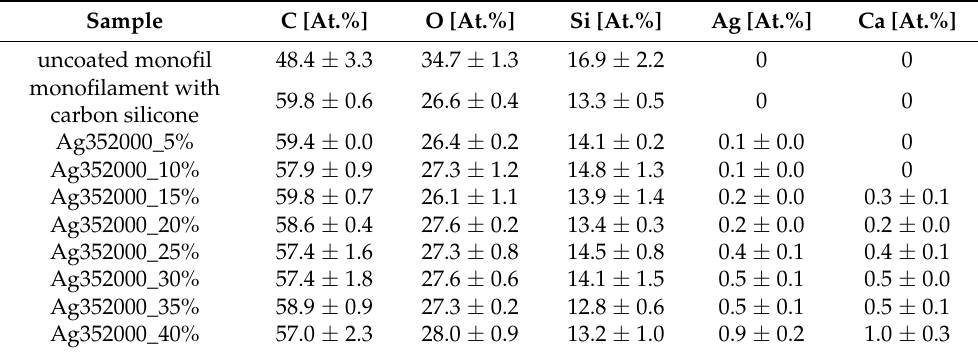
Table 3. Evaluation EDX analysis of samples with Ag352000 in different concentrations. The values represent mean values over three measurements. In some cases further elements, e.g., nitrogen, were detected. In this case, no new normalization was performed, but the output values were used. Sample C [At.%] O [At.%] Si [At.%] Ag [At.%] Ca [At.%] uncoated monofil 48.4 ± 3.3 34.7 ± 1.3 16.9 ± 2.2 0 0 monofilament with 59.8 ± 0.6 26.6 ± 0.4 13.3 ± 0.5 0 0 carbon silicone Ag352000_5%